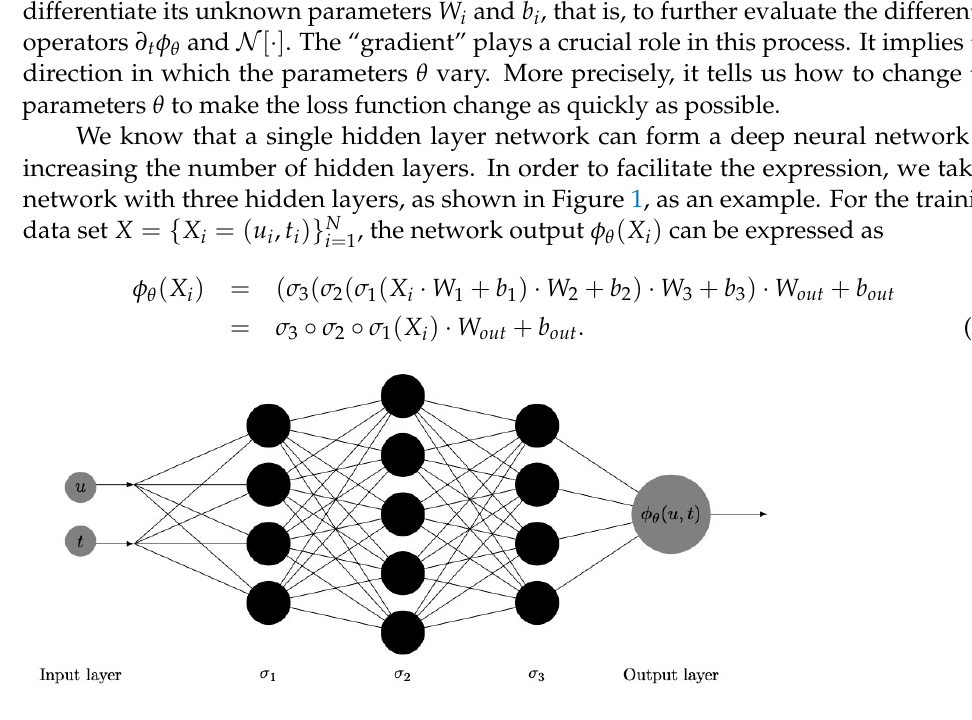
Figure 1. Illustration of a neural network with three hidden